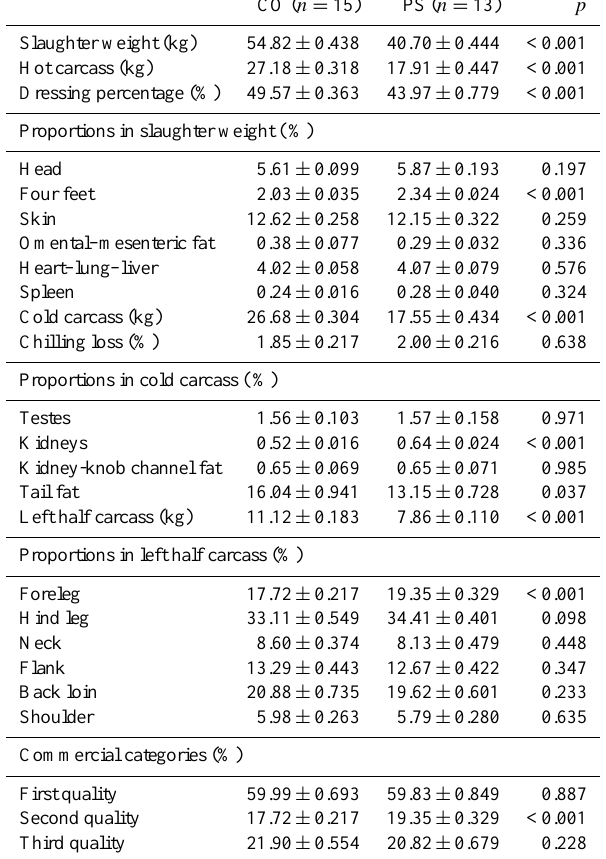
Table 3. Means for meat quality traits of concentrate (CO) and pas- ture lambs